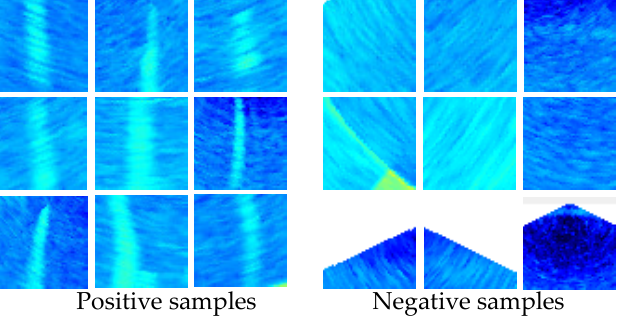
Figure 11. Part of the positive and negative samples with di ff erent object shapes. LBP and Haar-like descriptors are used for extracting the features of the positive and negative samples, and AdaBoost was used for getting the final detectors. Firstly, for comparison, the three detectors, which include the Haar-like detector, LBP-detector and Haar–LBP detector, were trained to detect the targets in the testing set. Then, in the case of using the same training set, testing set and bounding box generation method, the three detectors were evaluated for obtaining the optimal detector. In Figure 12, the PRC and ROC curves of the three detectors are shown. The smooth curves show that the training model does not have the overfitting phenomenon. The closer the ROC curve is to the upper-left corner, the more targets are correctly classified; or, the closer the PR curve is to the upper-right corner, the better the model performs. It is clear that the Haar-like detector outperforms the LBP detector. Since it is di ffi cult to compare the performance of the Haar–LBP detector and Haar-like detector from their curves directly, the AUC value of their curves can be used for comparison. As can be seen from Table 2, the AUC value of the Haar–LBP detector curve is greater than the other two, which proves that the detector proposed in this paper achieves better overall performance by combining the Haar-like and LBP